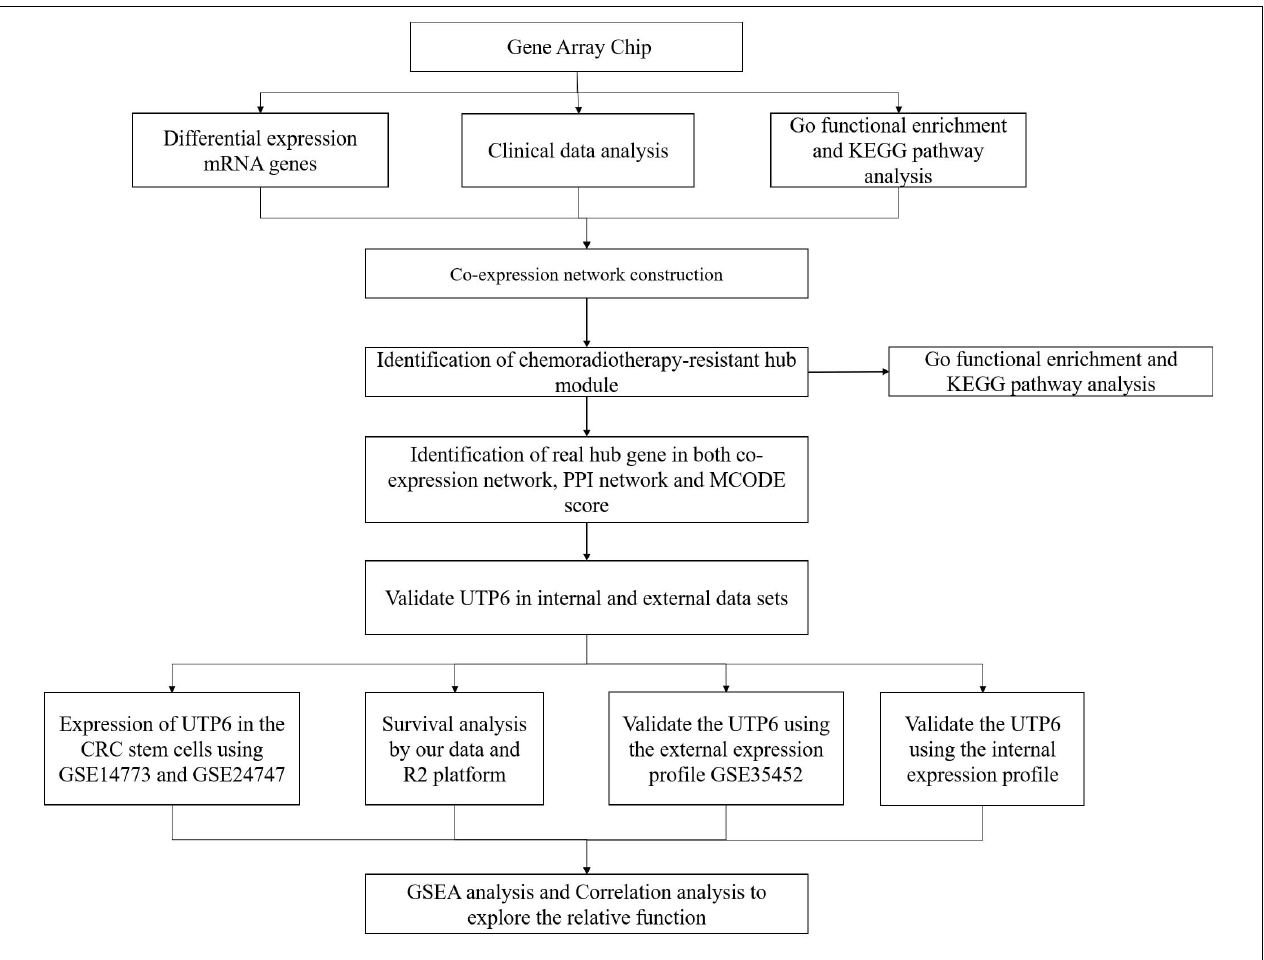
FIGURE 1 | Workflow diagram of data preparation, processing, analysis, and validation in this